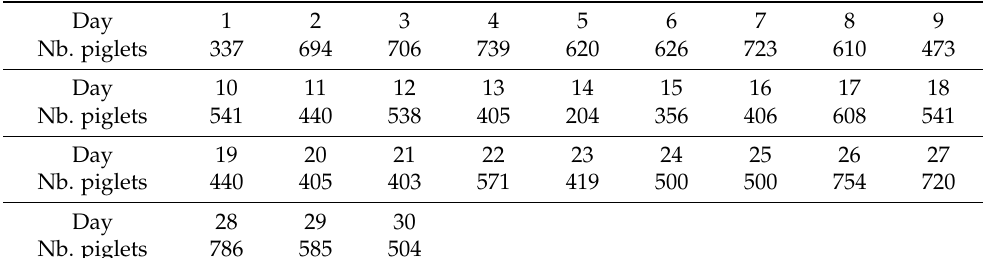
Table 3. Number of piglets with complete data recording on each day of the study.